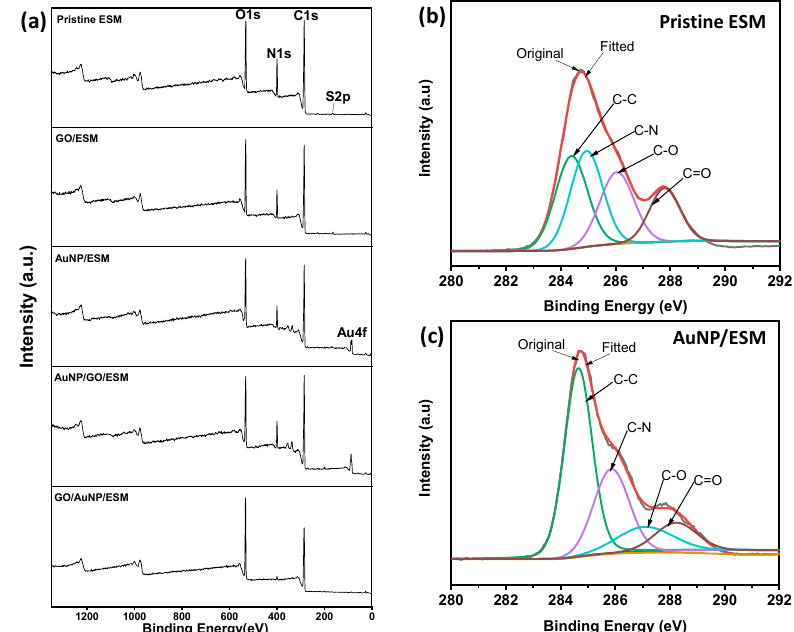
Figure 4. XPS spectra of ESM samples: ( a ) survey curves, and C1s XPS curve of ( b ) pristine ESM and ( c ) AuNP/ESM.